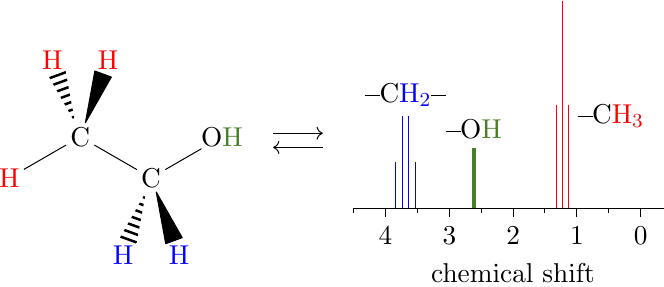
Figure 1 . Molecular structure of ethanol and its 1 H-NMR spectrum. The intensity, location and splitting of peaks allow us to identify the original molecular structure. The chemical shift is the resonant frequency of a hydrogen nucleus relative to a reference